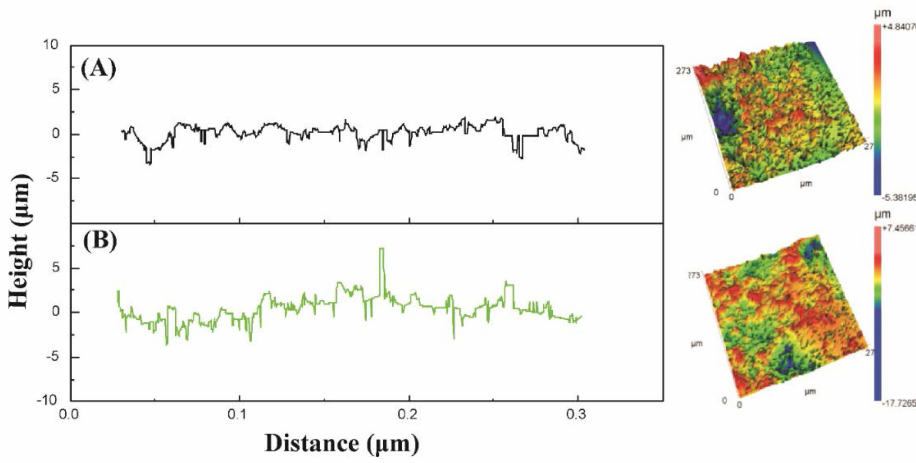
Figure 9. 3D maps and 2D profiles of the areas modified with 50 accumulated laser pulses: ( A ) at 1064 nm wavelength and output laser energy of 10 mJ (power density 3.3 GW/cm 2 ); and ( B ) at 532 nm wavelength and pulse laser energy of 25 mJ.